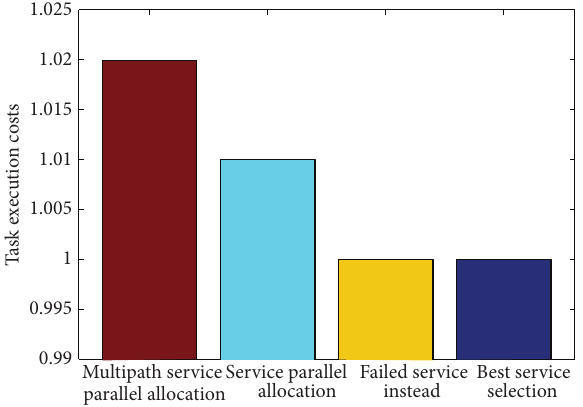
Figure 7: Comparison of the optimization result with different algorithms.